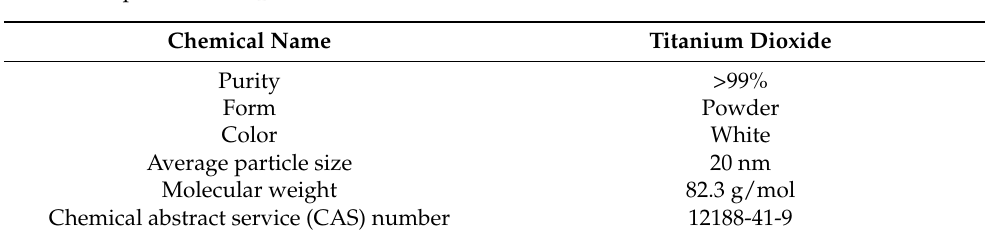
Table 2. Properties of TiO 2 .